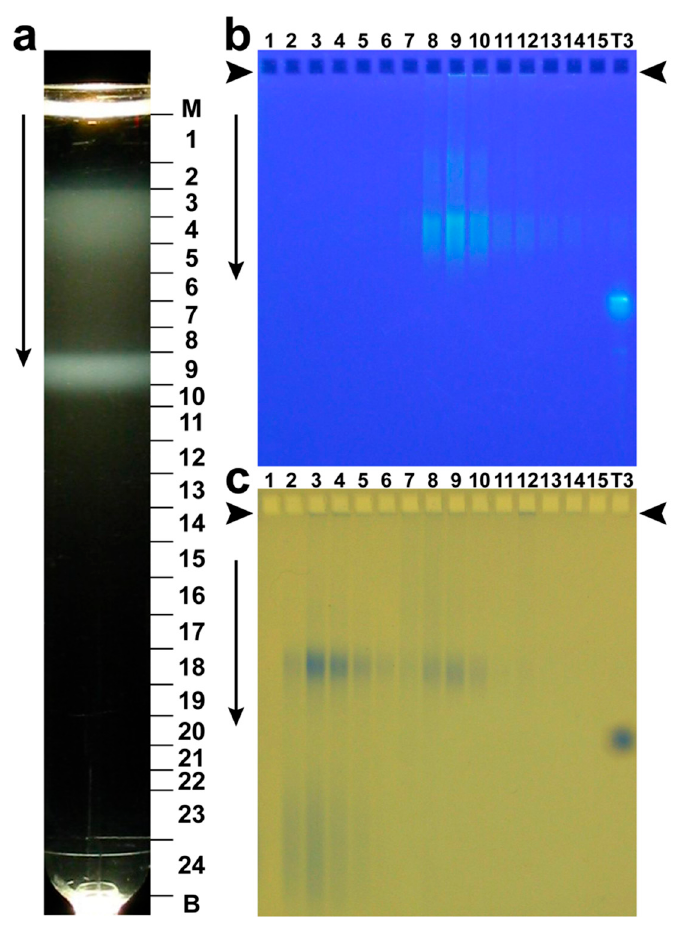
Figure 4. Purification of phage G by rate zonal centrifugation in a 10–35% linear sucrose gradient in the following buffer: 0.01 M Tris-Cl, pH7.4, 0.01 M MgCl 2 , 6% polyethylene glycol 3350 (Beckman SW41 rotor, 14,500 rpm, 1.0 h, 5 °C). The gradient had a volume of 10.8 ml and was poured over a 0.7 ml 62% sucrose shelf. ( a ) Photograph of the light scattering from the centrifuge tube (M, meniscus; B, tube bottom). ( b ) AGE of the fractions of panel ( a ), as indicated at the top of a lane, followed by nucleic acid-specific staining with GelStar. ( c ) The gel of ( b ) after protein-specific staining with Coomassie blue [39,47]. Electrophoresis was performed at 1.0 V/cm for 16.0 h. in a 0.4% submerged agarose gel (Seakem LE) in 0.09 Tris-Acetate, pH 8.3, 0.001 M MgCl 2 . The T3 lane in Figure 4b,c has phage T3 used as a control for band integrity. Some T3 DNA has leaked out of T3 phages; this DNA co-migrates with phage particles during AGE, as seen in the ( b ) panel. The vertical arrows indicate the direction of electrophoresis; arrowheads indicate the origins of electrophoresis.